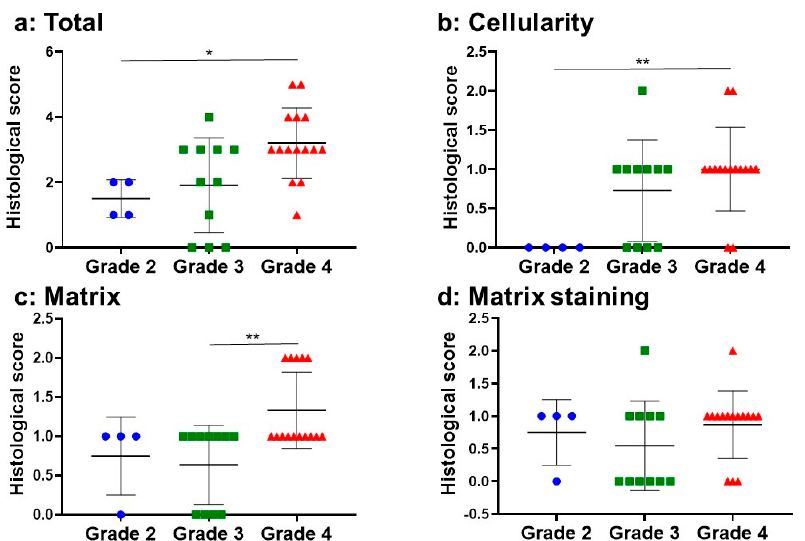
Figure 3. Histological classification of human NP tissues by Pfirrmann classification. ( a ): total, ( b ): cellularity, ( c ): matrix, ( d ): matrix staining. Grade 2 (n = 4), grade 3 (n = 11), grade 4 (n = 15). * p < 0.05, ** p < 0.01, Kruskal–Wallis test.